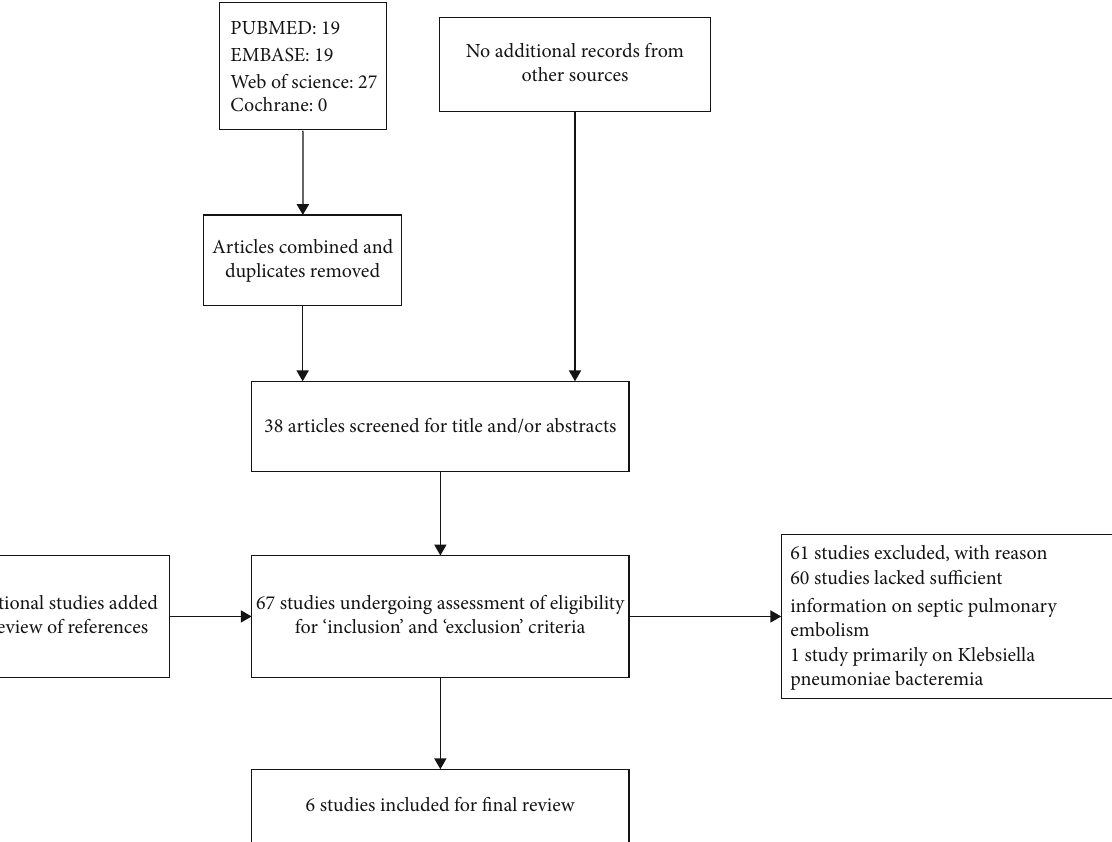
Figure 1: A schematic fl owchart of the Preferred Reporting Items for Systematic Reviews and Meta-Analyses (PRISMA) guidelines. Six studies were fi nally